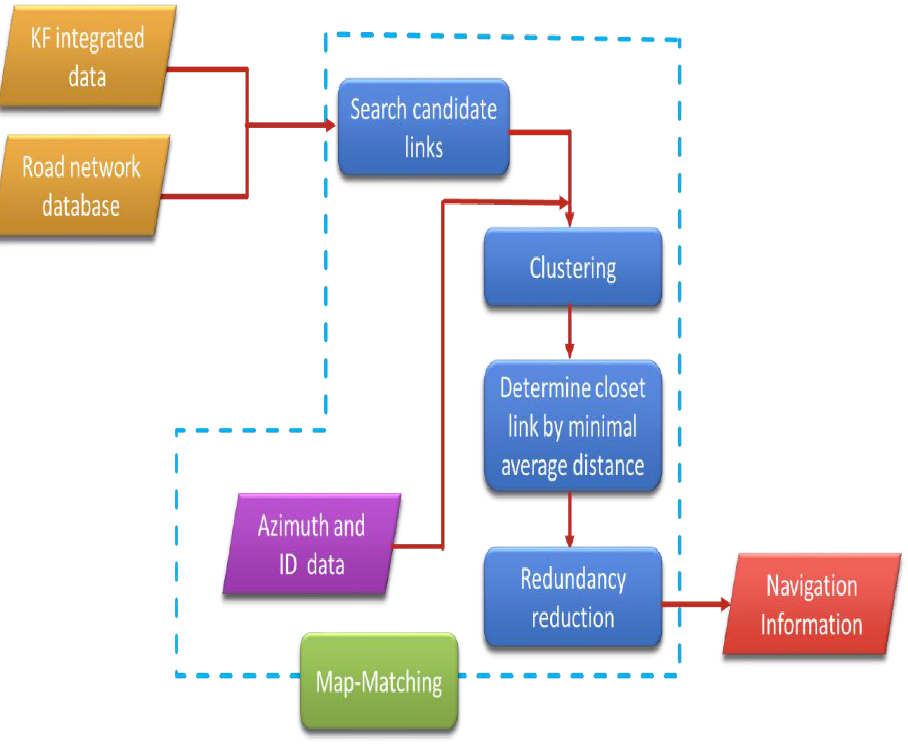
Figure 1. The map-matching